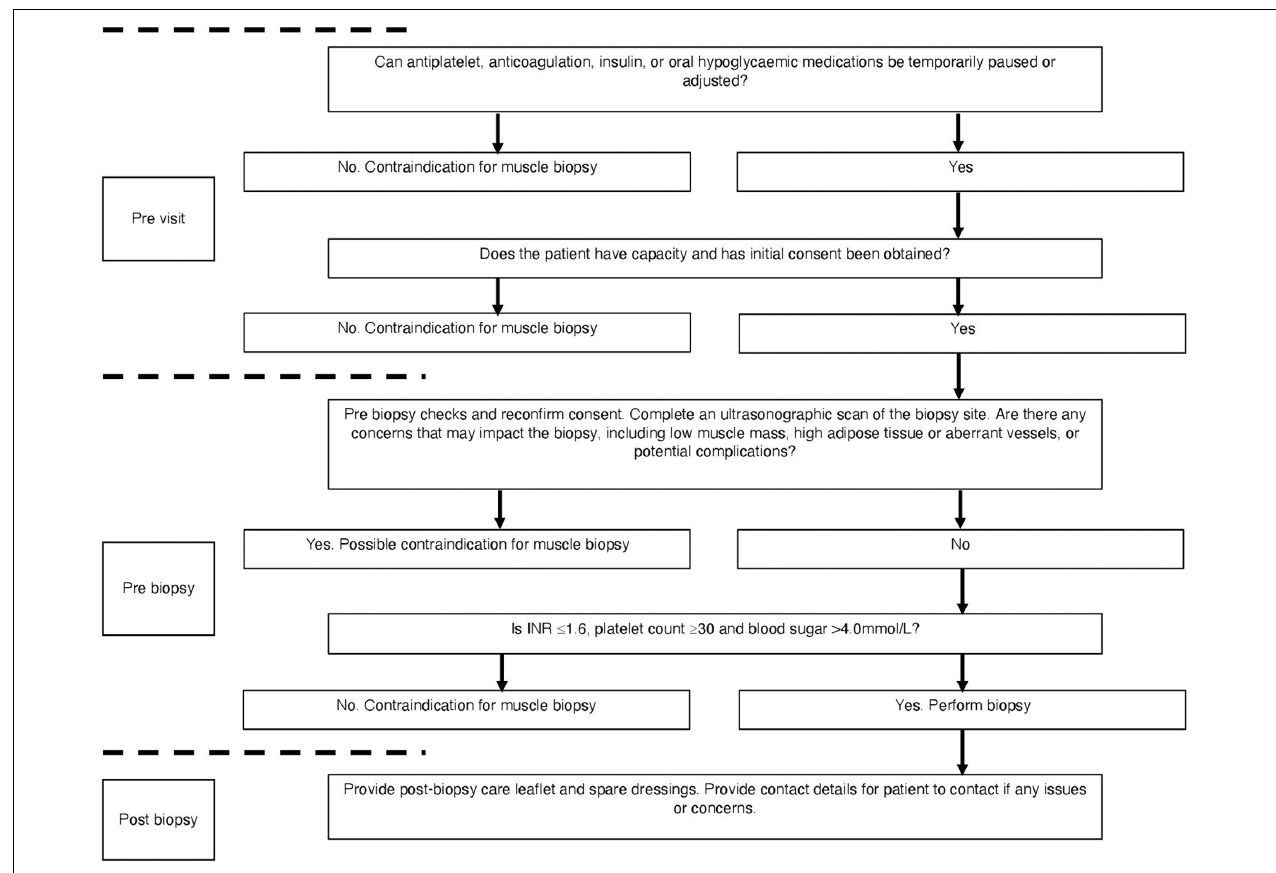
FIGURE 1 | Flowchart for safety considerations prior to muscle biopsy. Checks occur at pre-visit, pre-biopsy, and post-biopsy follow